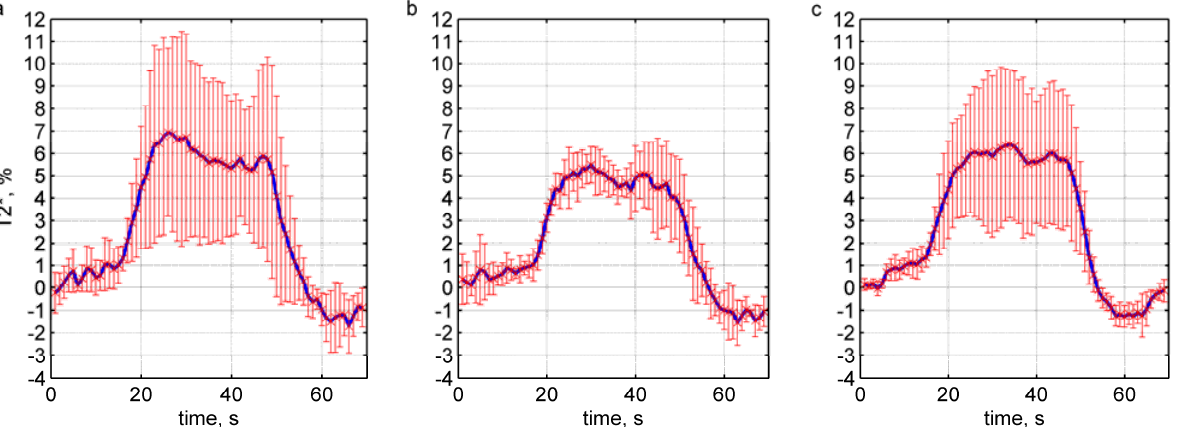
Figure 4. Time-locked T2* changes. Group event-related averages (blue) and their SD across subjects (red bars) for ( a ) PMC; ( b ) PMC NF; and ( c ) VC fSVPS time series are shown. Note that PMC NF time series showed much lower event-related standard deviations but also lower average signal change (b; see also Figure 5c).